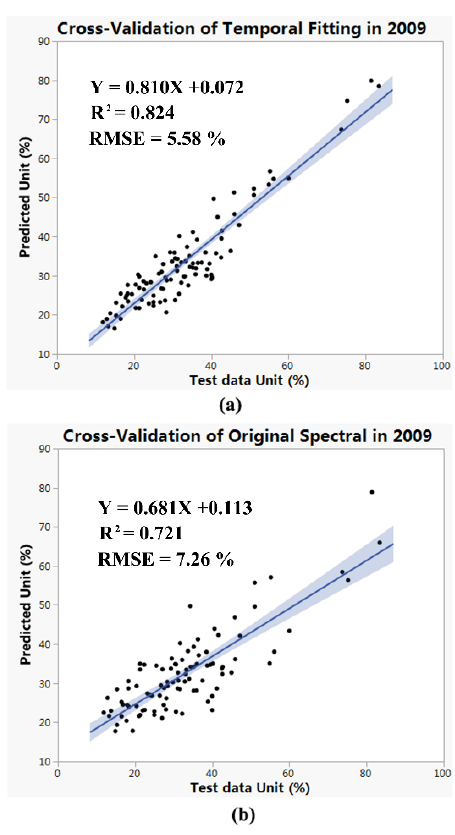
Figure 4. Scatter plots of predicted forest cover against LiDAR data results. ( a ) Validation of forest cover with temporal trajectory fitting algorithm; ( b ) validation of forest cover with original spectral indices. The blue area represents the 95% confidence intervals for the regression line.